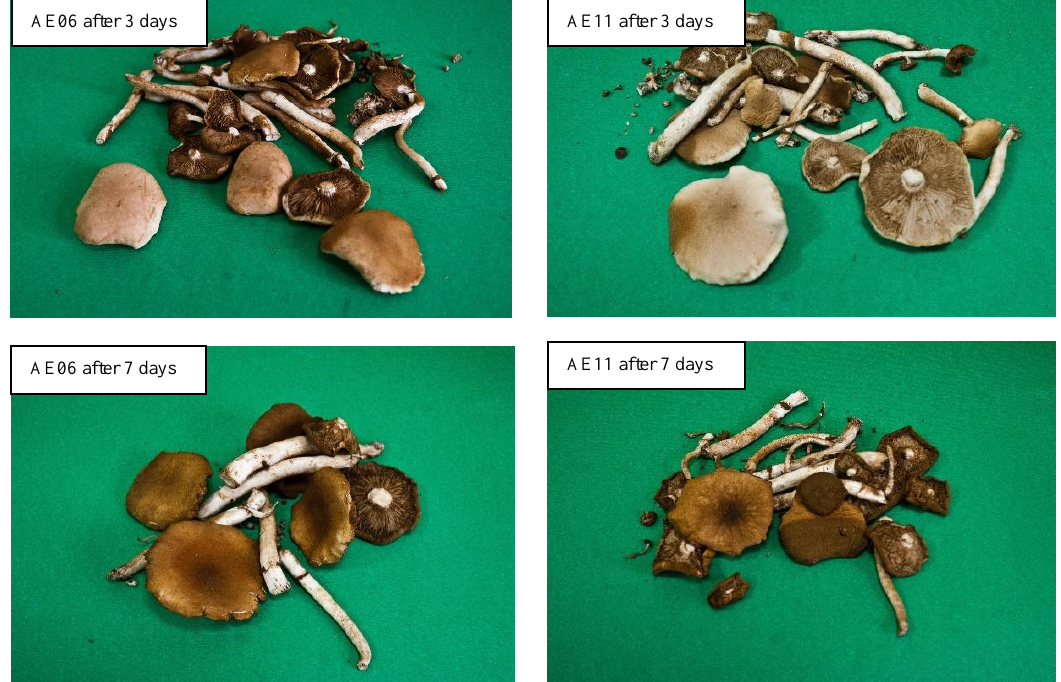
Figure 5. Fruiting bodies of strain AE06 obtained from substrate with addition of 4 g of CaCO 3 per 100 g DM substrate after 3 and 7 days of storage and fruiting bodies of strain AE11 obtained from substrate with addition of 8 g of CaCO 3 per 100g DM substrate after 3 and 7 days of